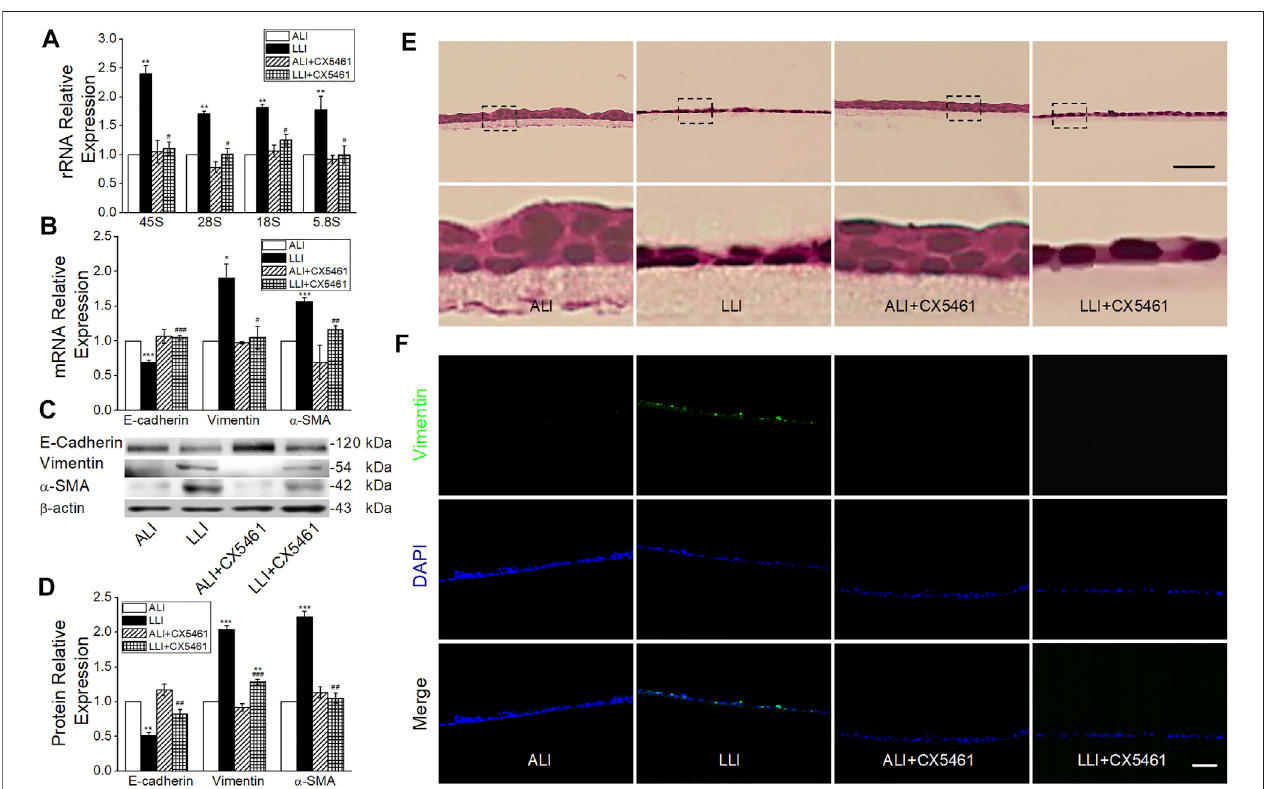
FIGURE 6 | CX-5461 abrogated hypoxia-induced EMT. (A) rRNA expression level after administration of 100 nM CX-5461 in the mode of LLI culture. ** p < .01, compared with ALI group, # p < .05 compared with LLI group, n (cid:1) 5. Mann – Whitney U test was used to analyze the difference of the means for signi fi cance. (B) ExpressionofE-cadherin, Vimentin,and α -SMA.* p < .05,*** p < .001, compared withALIgroup, # p < .05, ## p < .01, ### p < .001,comparedwithLLIgroup, n (cid:1) 3. (C – D) RepresentativeandstatisticaldataofEMTmarkers.** p < .01,*** p < .001comparedwithALIgroup, ## p < .01, ### p < .001,comparedwithLLIgroup, n (cid:1) 3 – 4.One- way ANOVA followed by Bonferroni ’ s test was used toanalyze the difference of the means for signi fi cance. (E) HE staining. The nether line of images was enlarged from the upper original image. (F) Immuno fl uorescence of Vimentin (green). The nucleus was stained with DAPI (blue). Scale bar (cid:1) 50 μ m.